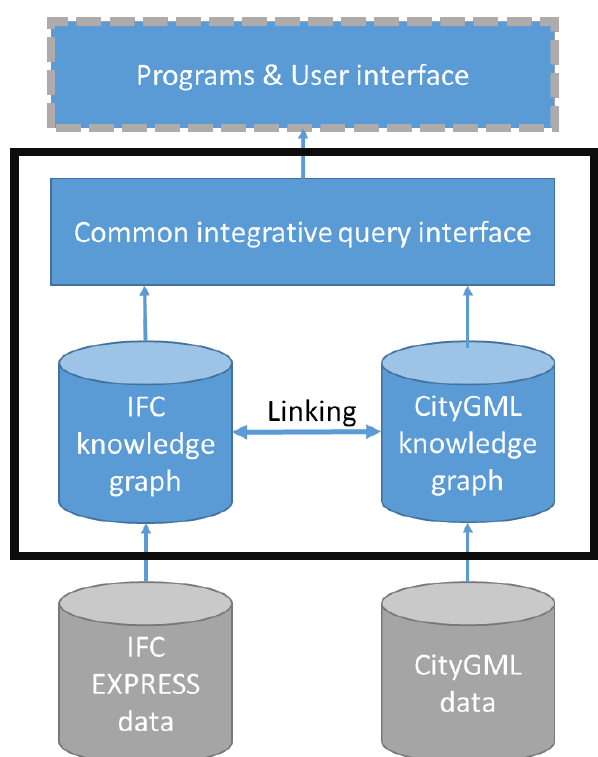
Figure 2. System architecture of GeoBIM data integration